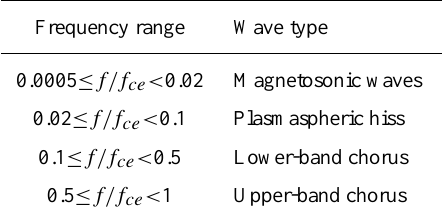
4 Distributions of spectral density